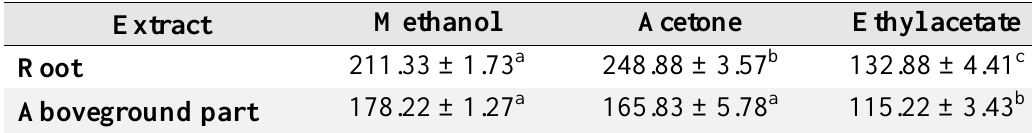
Table 6. The total amount of phenols determined in different Rumex acetosella extracts presented as equivalents of gallic acid, mg of GA/g